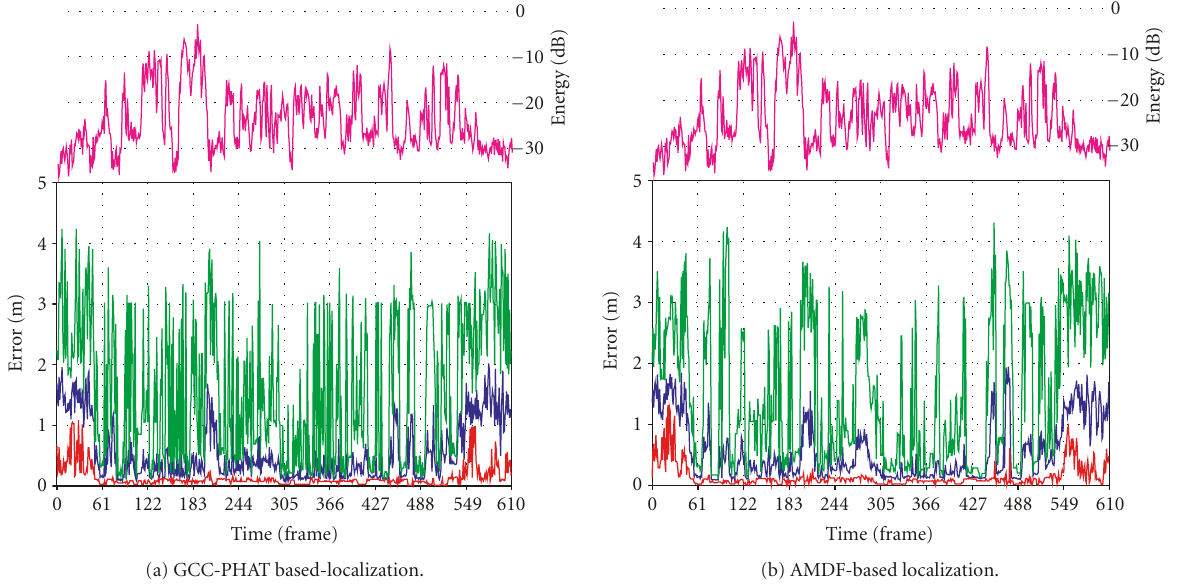
Figure 11: Localization error for the same audio sequence as in Figure 8 computed over 8 subbands. Averaged error over all subbands is displayed in blue, maximum error in green and minimum error in red. The top (magenta) curve represents the energy for one of the input recordings and shows its correlation with the localization error (clearly larger when the energy drops out).